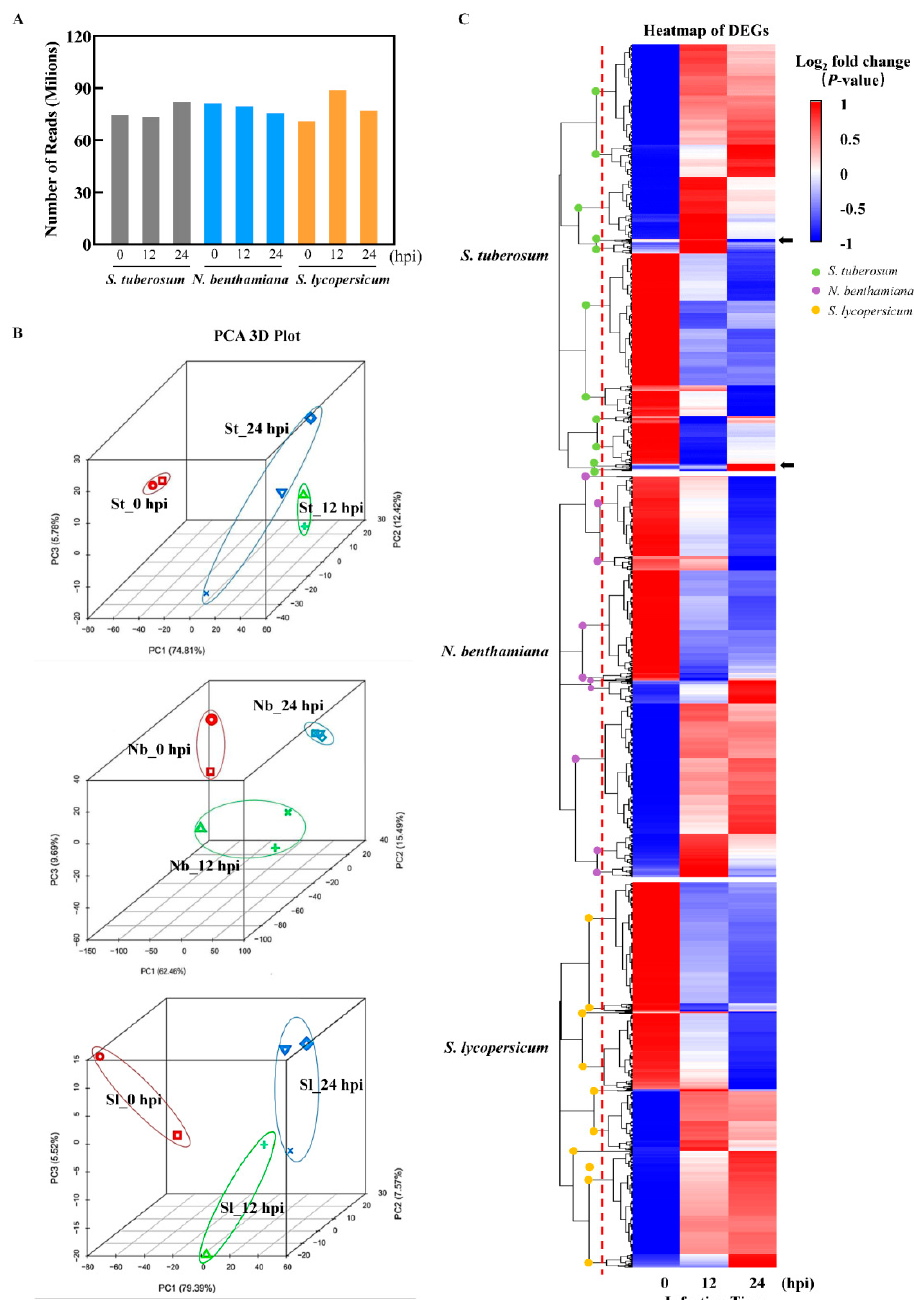
Figure 2. Summary of the initial analysis for the transcriptome data. ( A ) High-quality clean reads from high-throughput sequencing. Total leaf RNA from S. tuberosum , N. benthamiana and S. lycoper- sicum infected by P. infestans at 0, 12 and 24 hpi were used to prepare the high-throughput sequencing library. ( B ) Principal component analysis of differentially expressed genes was employed to visualize the distinction between TSHs infected by P. infestans at 0, 12 and 24 hpi. The upper, middle and bottom parts are S. tuberosum (St), N. benthamiana (Nb) and S. lycopersicum (Sl), respectively. The same color represented the repetition of the sample. ( C ) The heat-map of DEGs of TSHs induced by P. infestans . The color scale showed the values (log2 fold change). The red dotted-lines represented the locations where TSHs were compared in cluster numbers, and the clusters were compared using different colors dots with green ( S. tuberosum ), purple ( N. Benthamiana ) and orange ( S. Lycopersicum